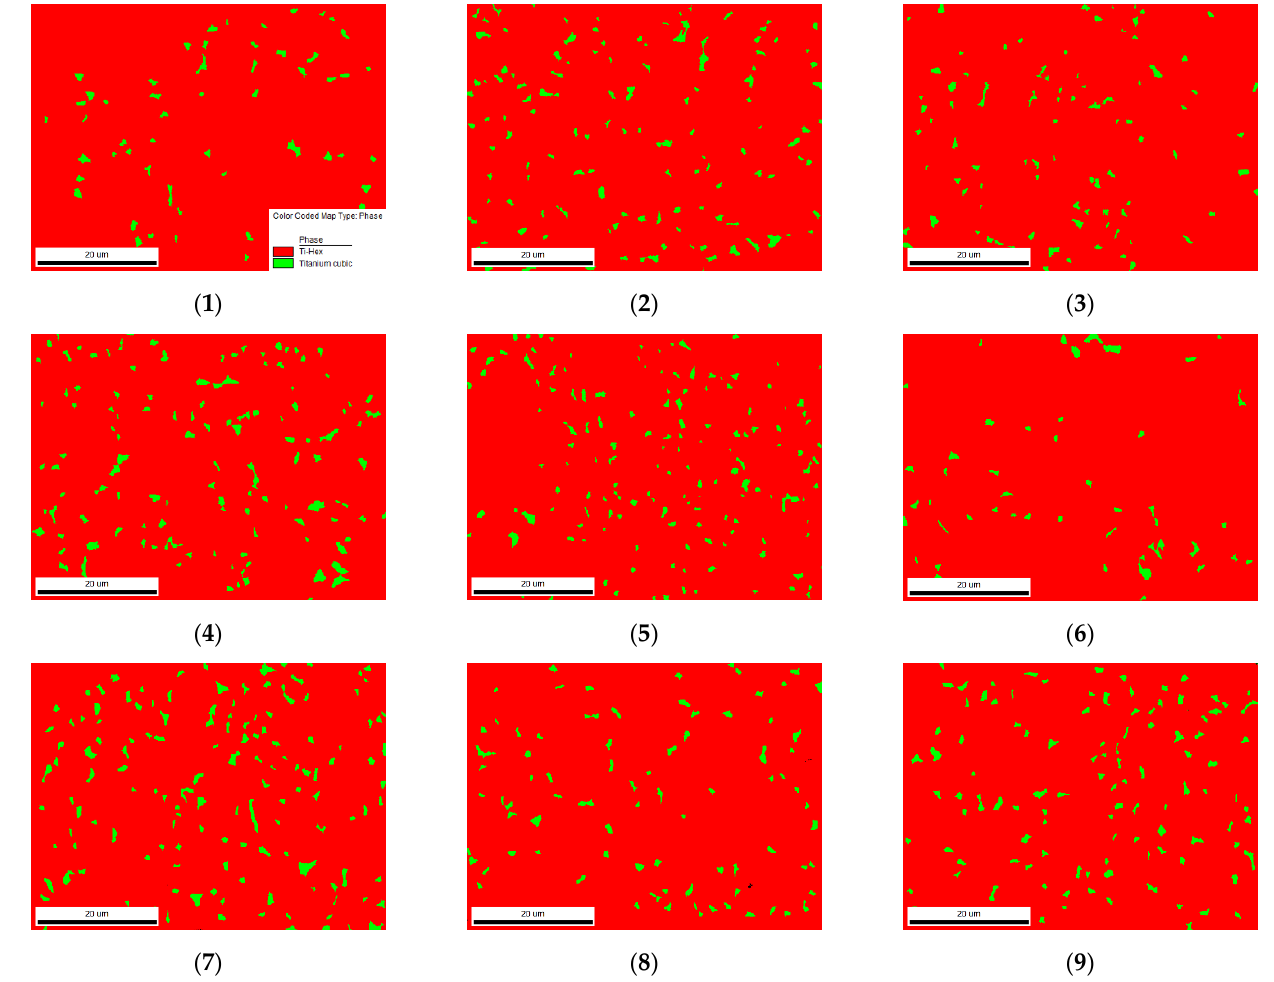
Figure 12. The grain boundary distribution maps of Ti-6Al-4V under different milling parameters.